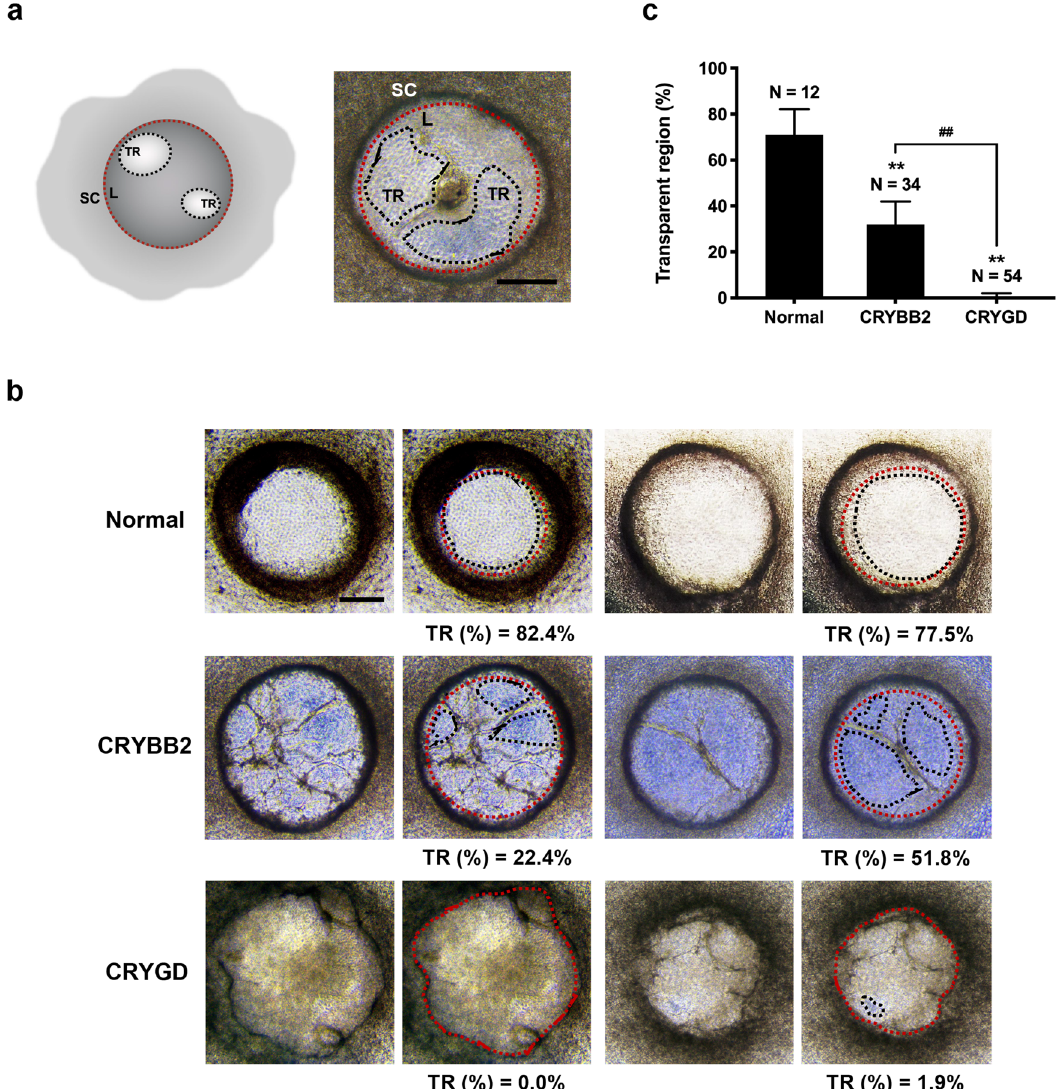
Fig. 2 Quantitative analysis of LB opaci fi cation. a Left panel: Schematic illustrating the method of measuring the fractional area of transparent regions (TR%) in the LBs. Right panel: Representative image of a LB showing the method of fractional area measurement. L: LB; TR: transparent region; SC: supporting cells. The dashed red lines indicate the borders of the LBs. The blue dashed lines indicate the borders of transparent regions. Scale bars: 200 μ m. b Representative images and the TR% of the normal, CRYBB2 -, and CRYGD -mutated LBs. The dashed red lines indicate the borders of LBs. The blue dashed lines indicate the borders of transparent regions. Scale bars: 200 μ m. c TR% analysis of the normal, CRYBB2 -, and CRYGD -mutated LBs. The data are presented as mean ± SD. ** p < 0.01 versus normal, ## p < 0.01 versus the indicated